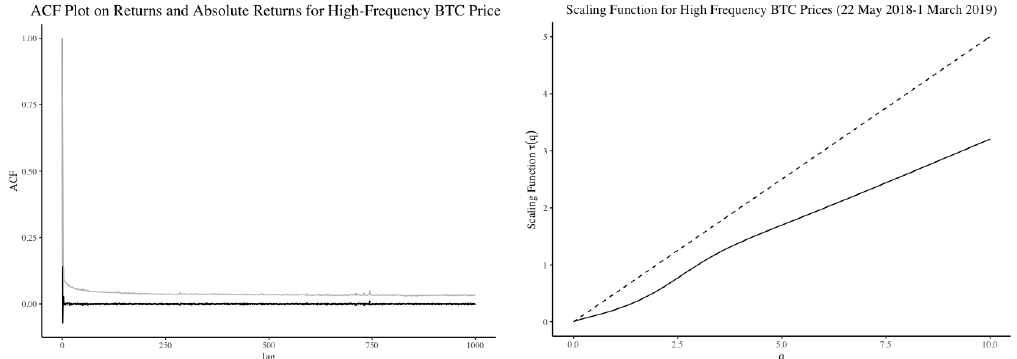
Figure 9. Left —Autocorrelations of mean-centered log returns (black) and absolute returns (grey) for high frequency Bitcoin open prices (22 May 2018–1 March 2019). Right —Scaling function for high frequency Bitcoin open prices (22 May 2018–01 March